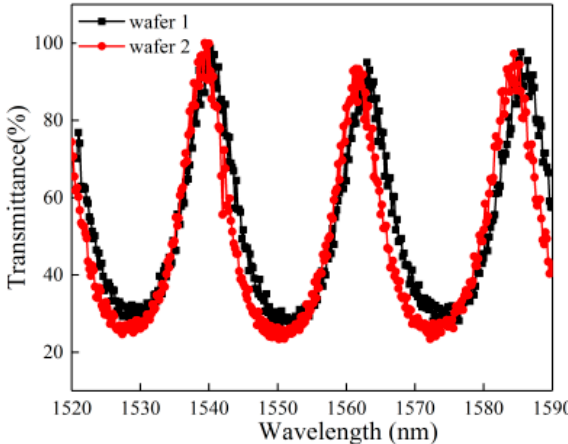
Figure 2. Transmission spectra of two ultra-thin silicon wafer.